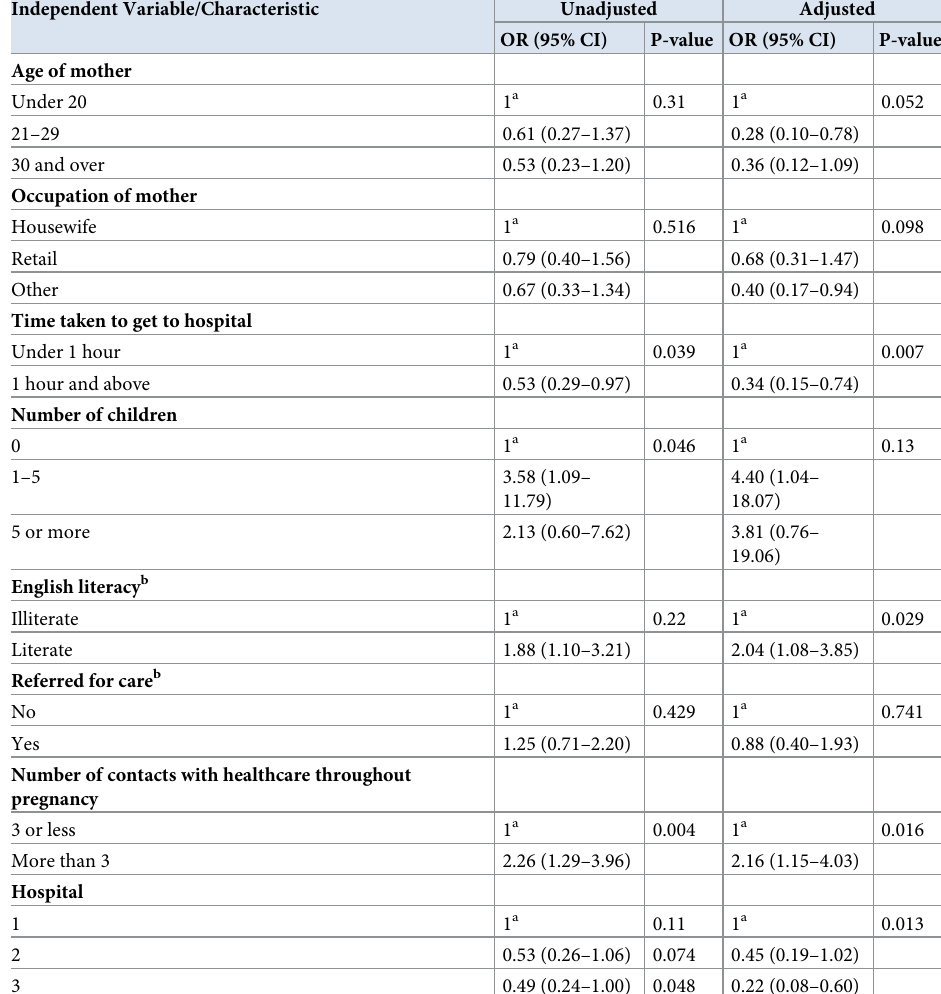
Table 3. Results of logistic regression analyses exploring associations between women’s characteristics and the likelihood of their documentation containing at least 8 out of 9 minimum